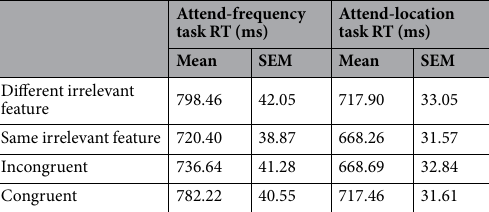
Table 1. Group mean and standard error of the mean response times from both TAiL tasks for different and same irrelevant feature changes, and incongruent and congruent feature